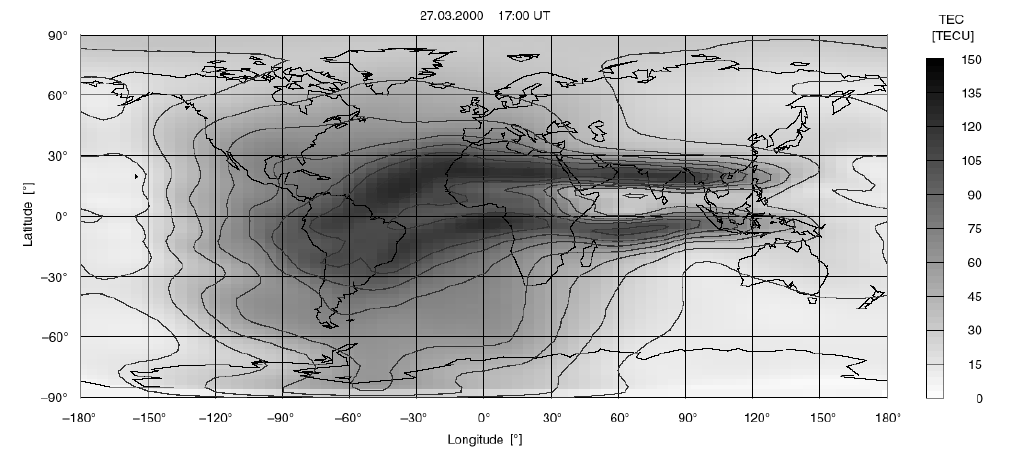
Fig. 1. Example of global vertical TEC map produced with La Plata technique for the day 27 March 2000, 17:00